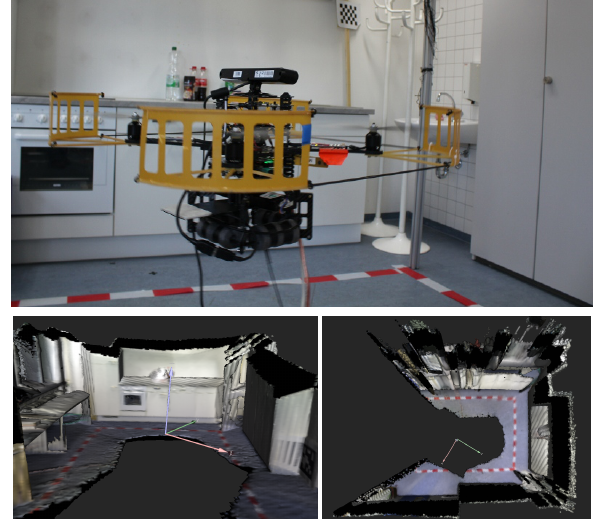
Figure 1: We present an efficient method for 3D reconstruction of indoor scenes using a quadrocopter equipped with an RGB-D camera. Top: AscTec Pelican platform used in our experiments. Bottom: Two different views on the reconstructed 3D model of our lab